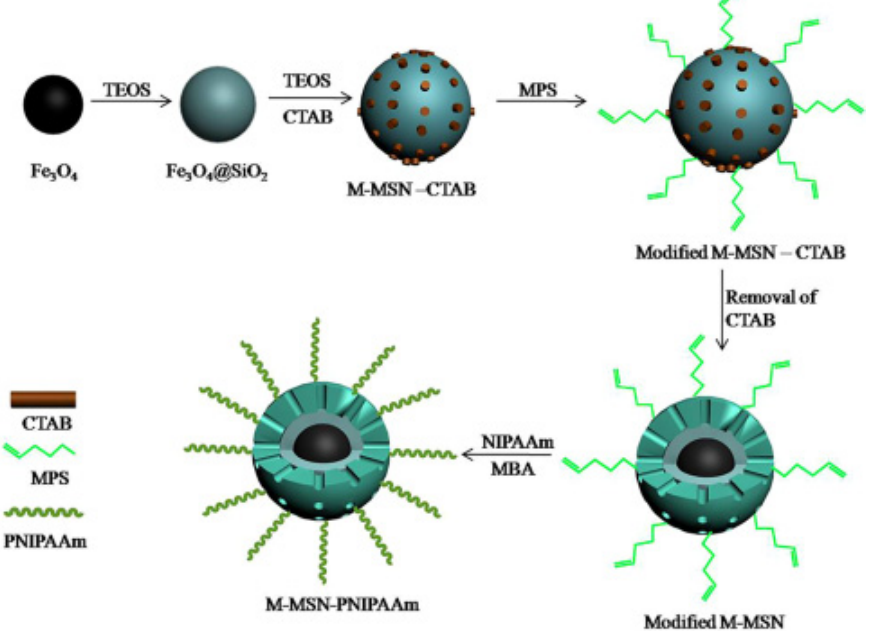
Figure 11. Schematic illustration of a multi-responsive Au@MSN@Valve. Reproduced with permission from [105]. Copyright American Chemical Society, 2012.